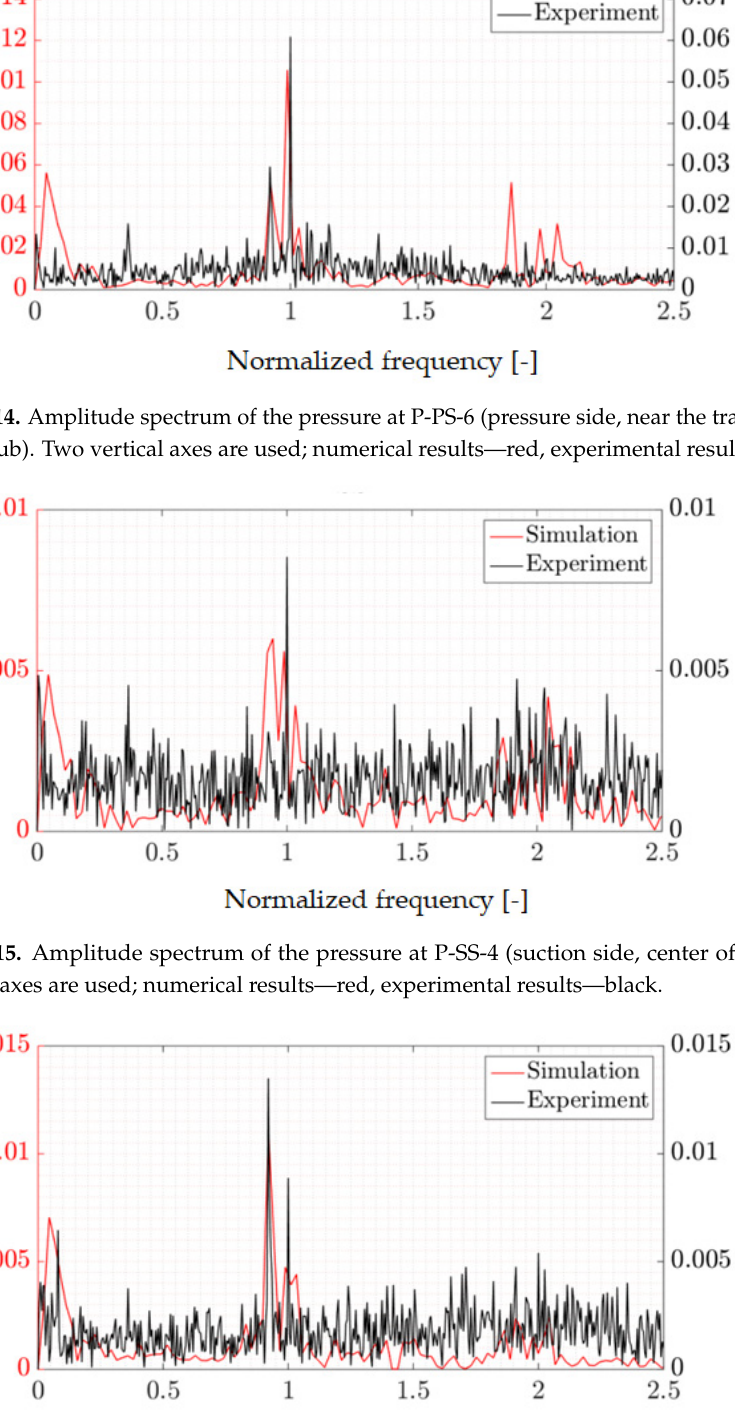
Figure 16. Amplitude spectrum of the pressure at P-SS-3 (suction side, near the trailing edge). Two vertical axes are used; in red are the numerical results and in black are the experimental results.